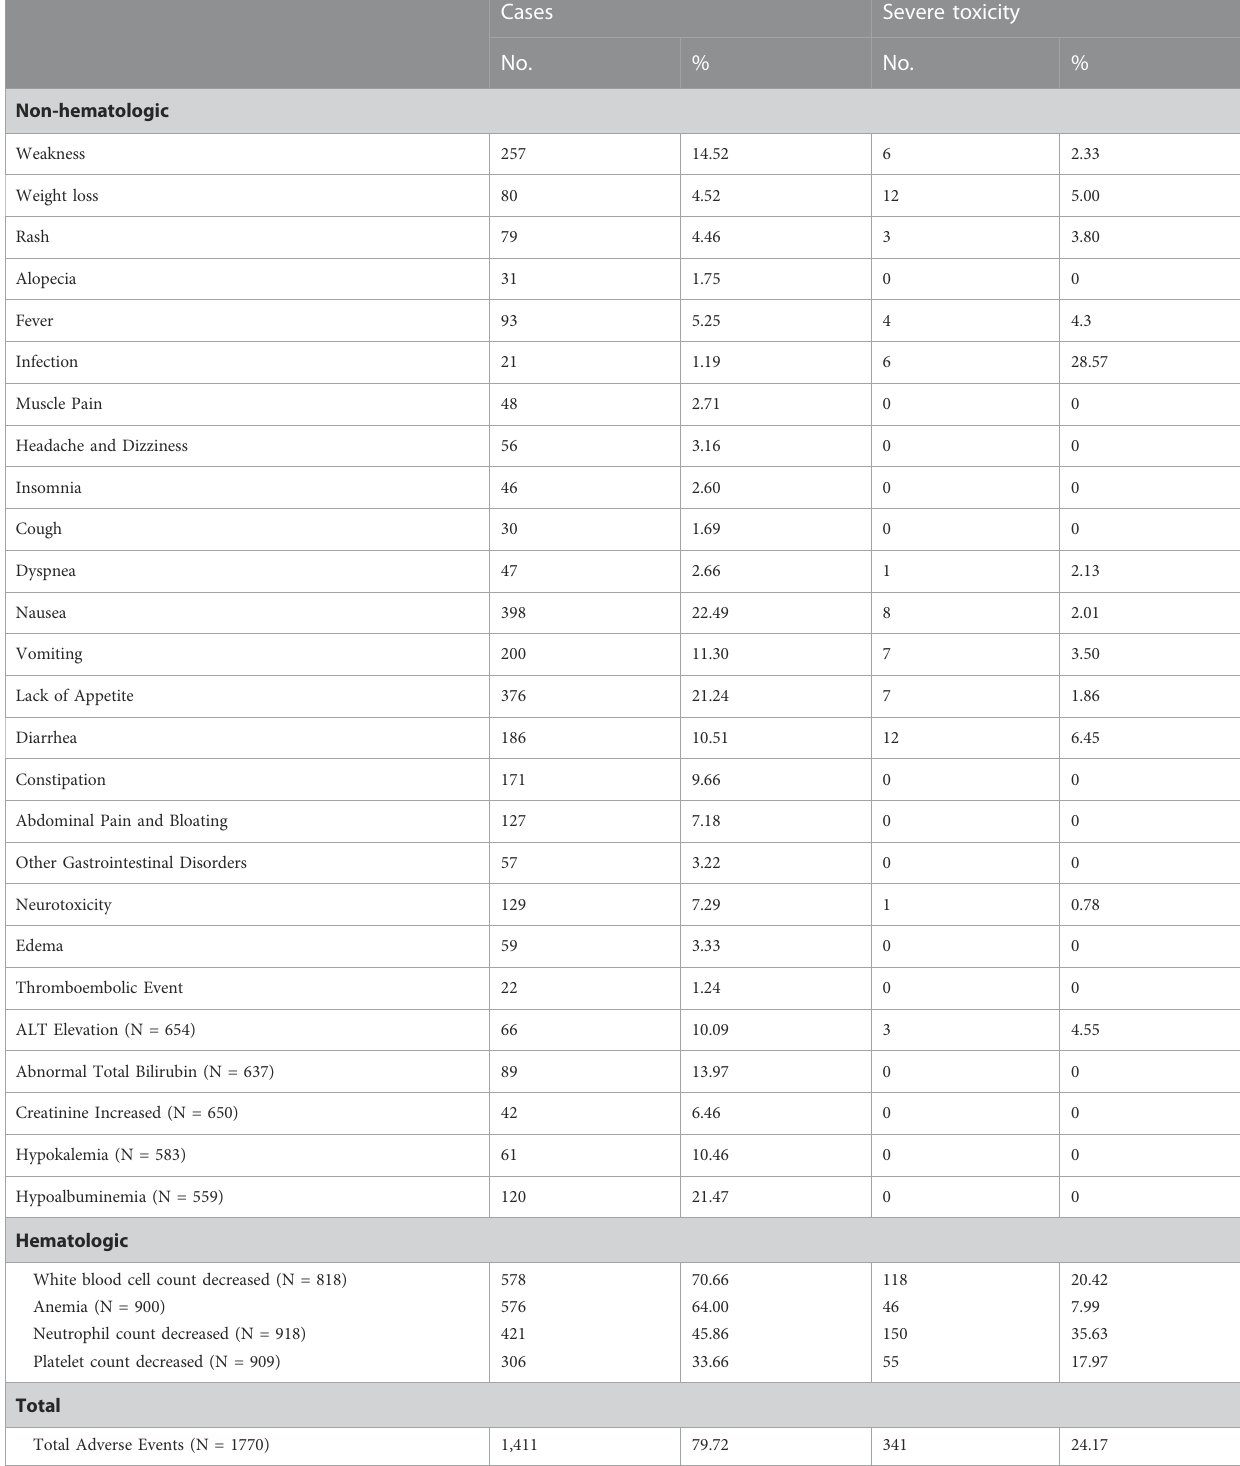
TABLE 2 Treatment-related adverse events.